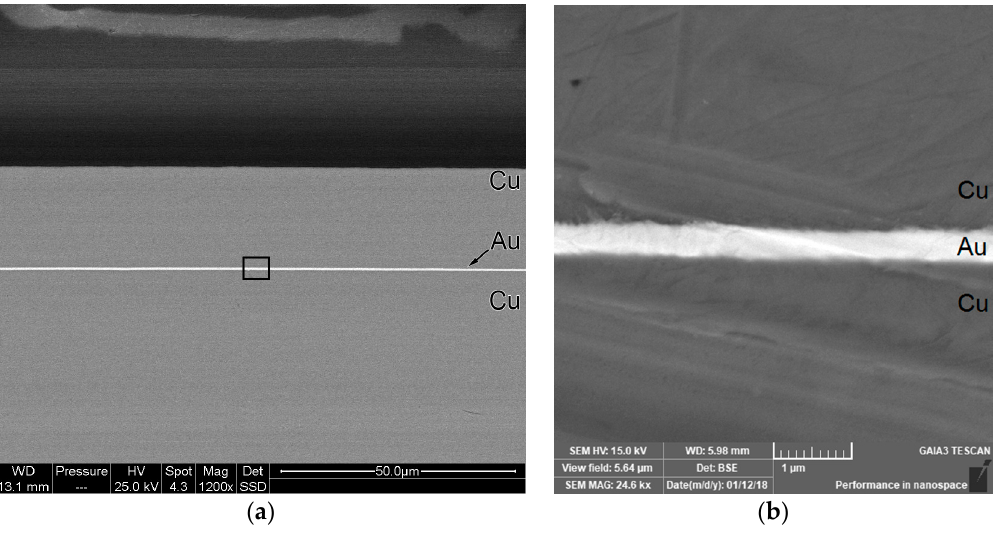
Figure 2. Cross section of gold sample: ( a ) 1200× magnification to show the external galvanic copper coating, the boxed area is magnified in ( b ); ( b ) film detail, used for the quantification, 24600× magnification.